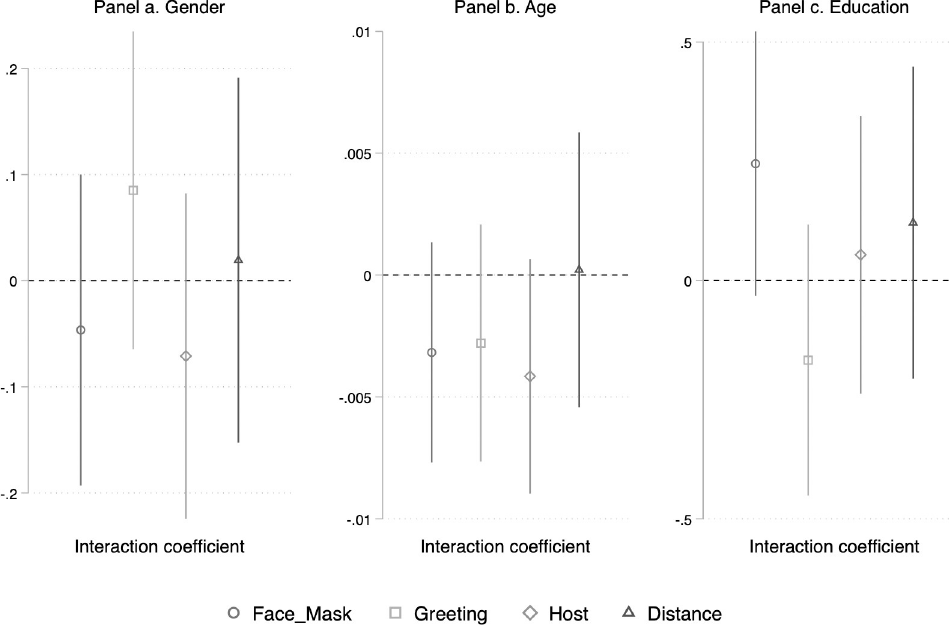
Fig 2. Interaction coefficients for the guilt-free treatment, by gender, age and education. Note: The values of the interaction coefficients estimated in Tables C.1-C.3 of the S1 File are shown, with 95% confidence intervals included.